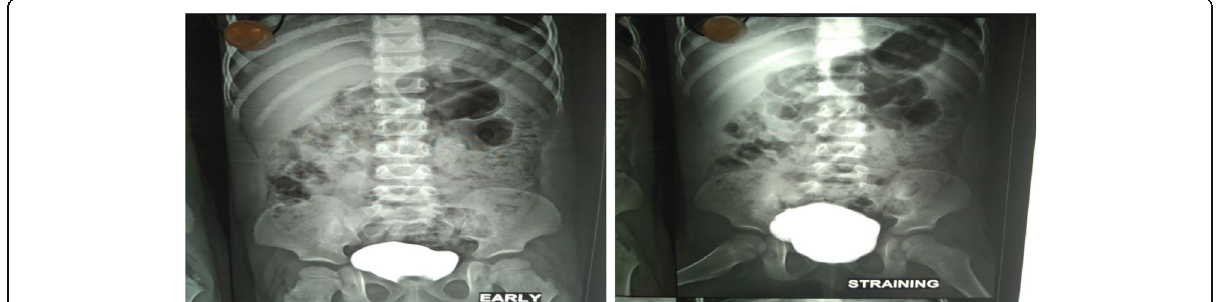
Fig. 3 VCUG in 9 years patient showing normal bladder configuration during early and voiding